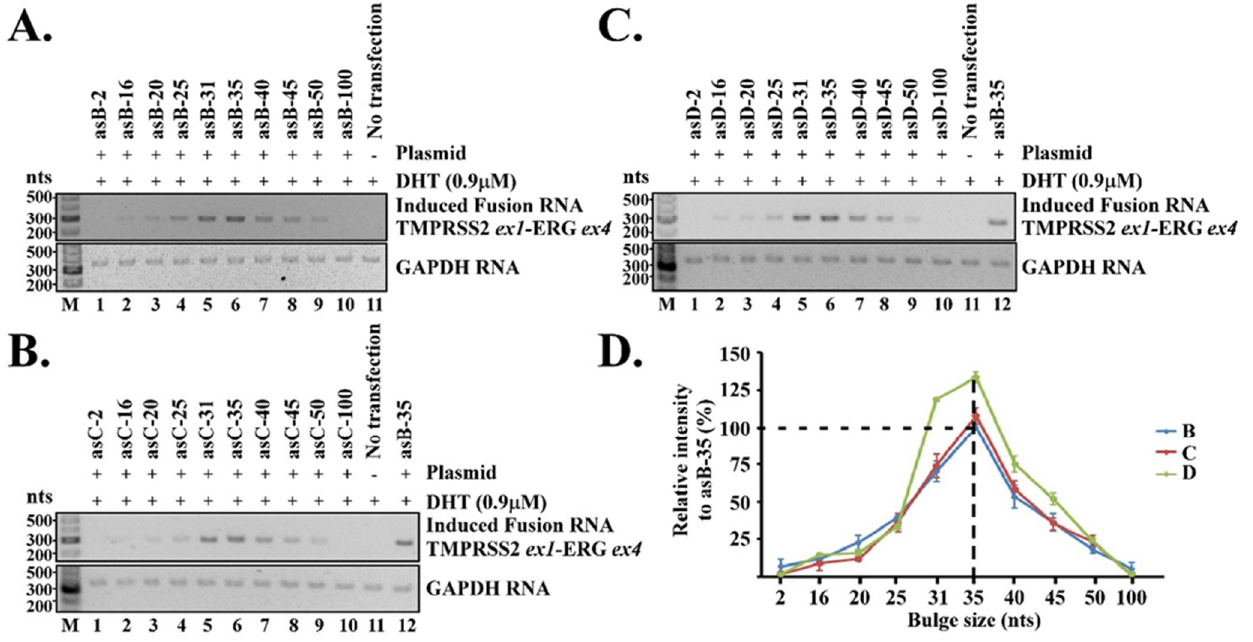
Figure 2. The bulge size regulated the efficiency of RNA-mediated gene fusion. A set of ten different antisense chimeric RNAs were designed to create different bulge sizes when annealed to each targeted location described in Figure 1. LNCaP cells were transfected with designed chimeric RNAs and treated with 900 nM of DHT for three days. RT-PCR was then performed to detect the level of induced TMPRSS2-ERG fusion RNA. GAPDH RNA was used as loading control. No transfection was used as the negative control for RT-PCR reactions. ( A ) RT-PCR results of induced TMPRSS2-ERG transcripts by chimeric RNAs designed to target location B. ( B ) RT-PCR results by chimeric RNAs designed to target location C. ( C ) RT-PCR results by chimeric RNAs designed to target location D. ( D ) All experiments were repeated independently thrice starting from cell transfection to RT-PCR and quantifications. Quantitation was done using ImageJ software. The average band intensities from three independent experiments were plotted as a line graph against the bulge size. Error bars represent standard deviations. The dashed line marks the most effective bulge size. The induced TMPRSS2-ERG fusion RNA level by antisense chimeric RNA ‘asB-35′ was used as the relative 100%.